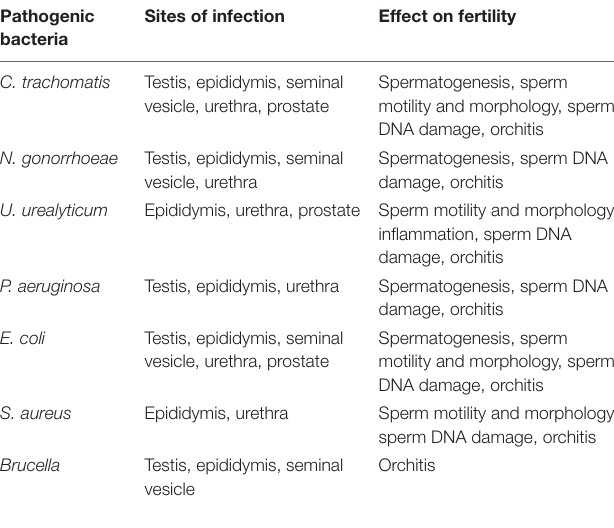
TABLE 1 | Common bacterial infection and its effect on male